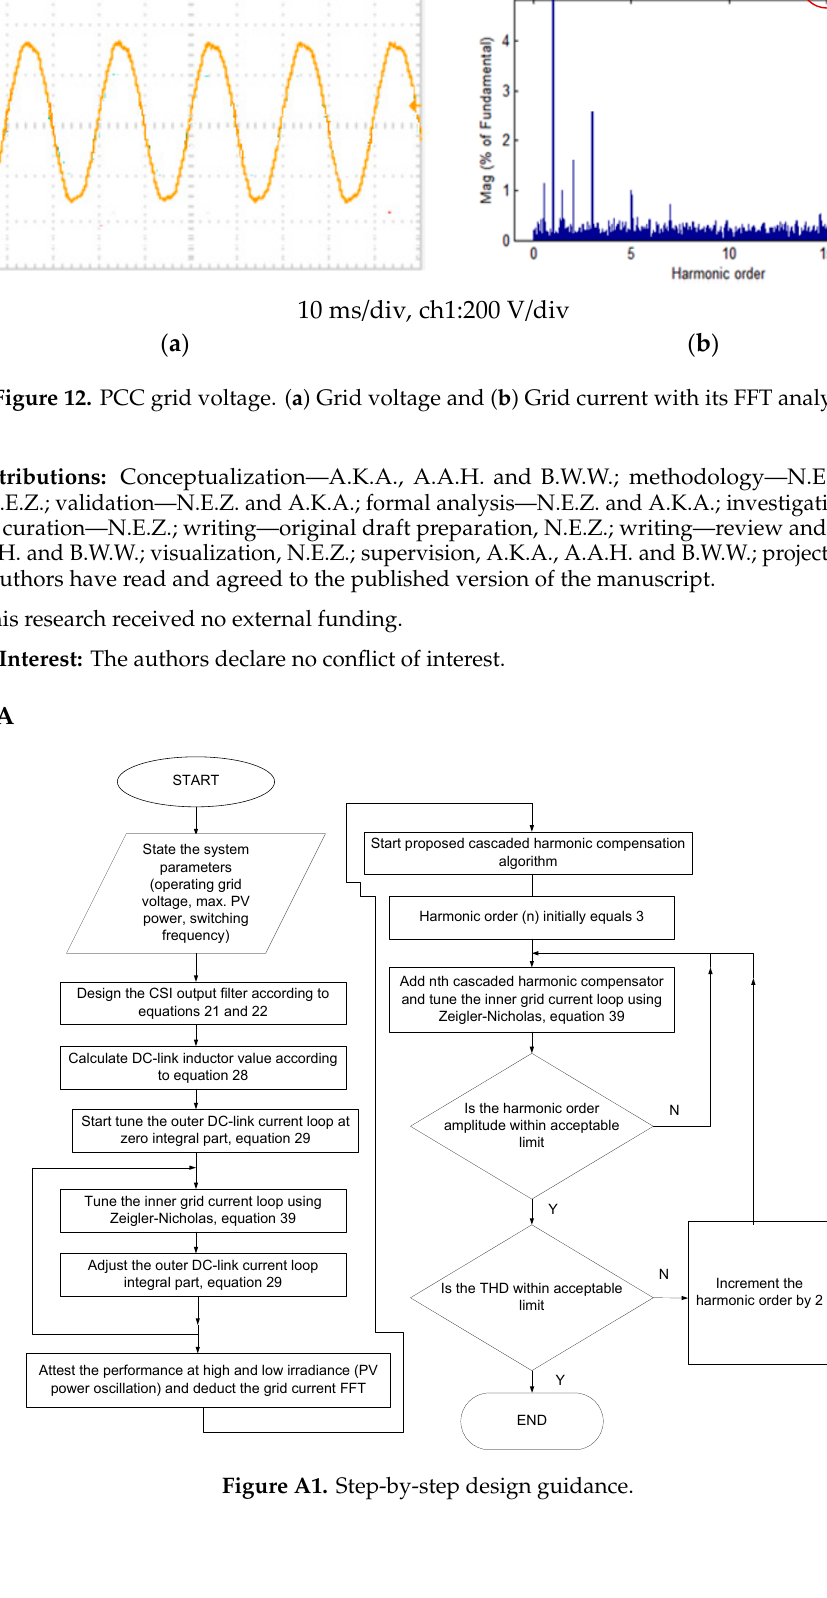
Figure A1. Step-by-step design guidance.